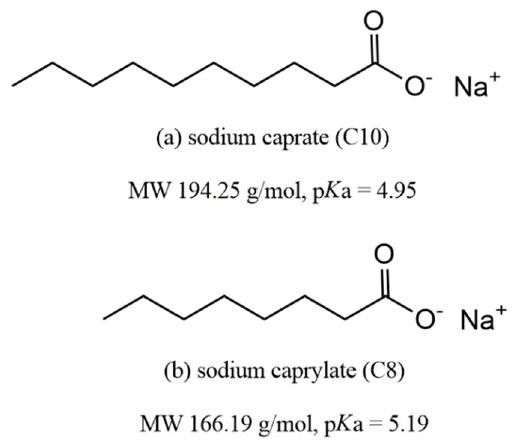
Figure 2. Structures of sodium caprate (C10) and sodium caprylate (C8).